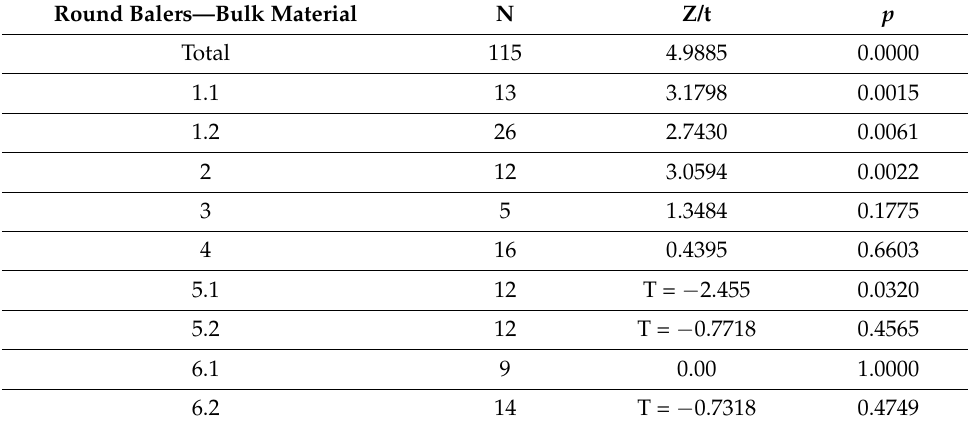
Table 6. Comparison test of two dependent means between CF and CB; Wilcoxon and Student’s t depending on the fulfillment of